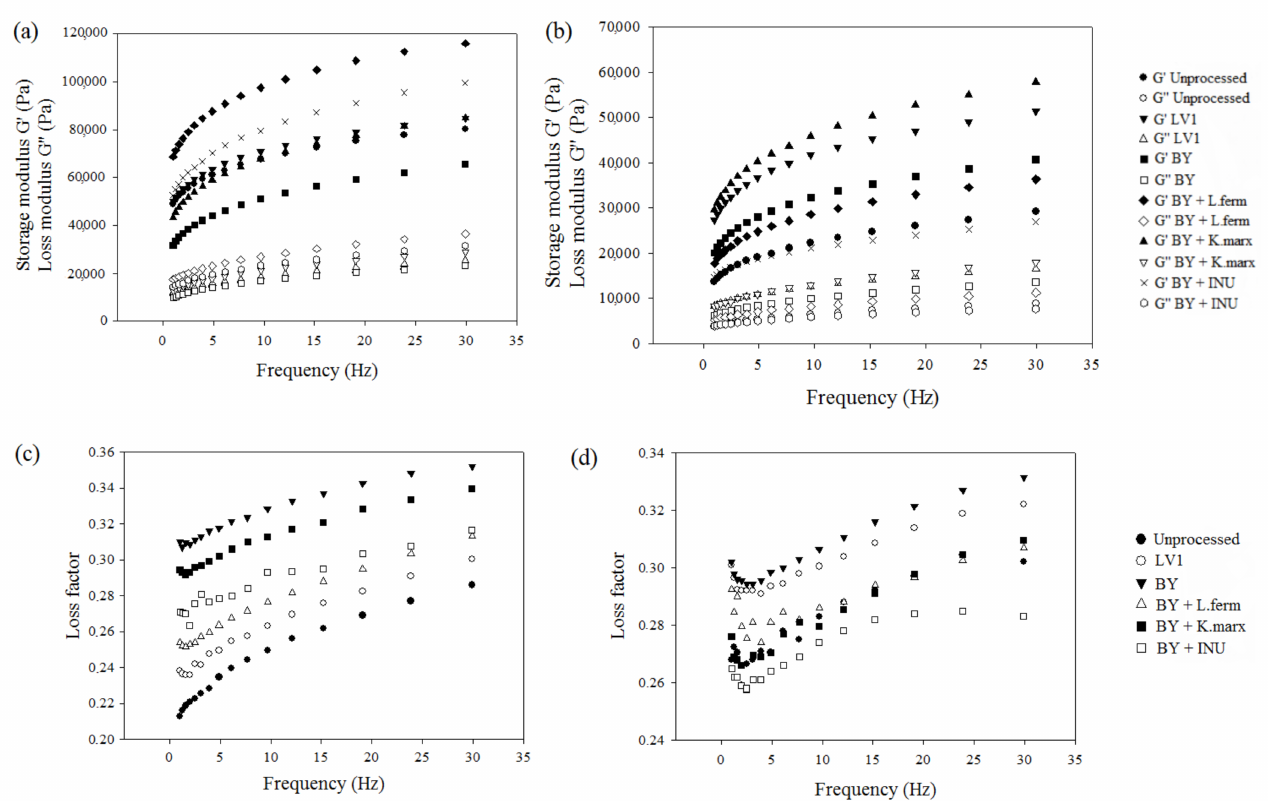
Figure 3. Storage and loss moduli of: ( a ) wheat bran; ( b ) amaranth bran, and loss factor of: ( c ) wheat bran; ( d ) amaranth bran. BY, bakery yeast; INU,